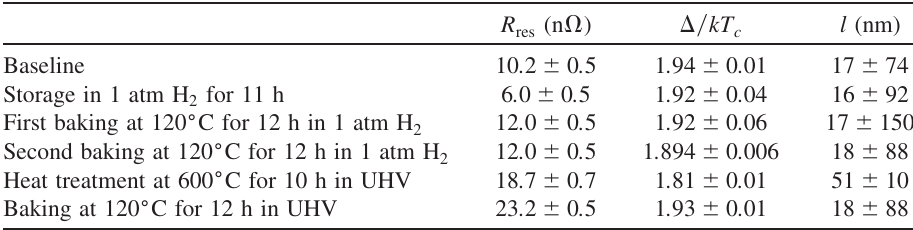
TABLE II. Weighted average values of R after various